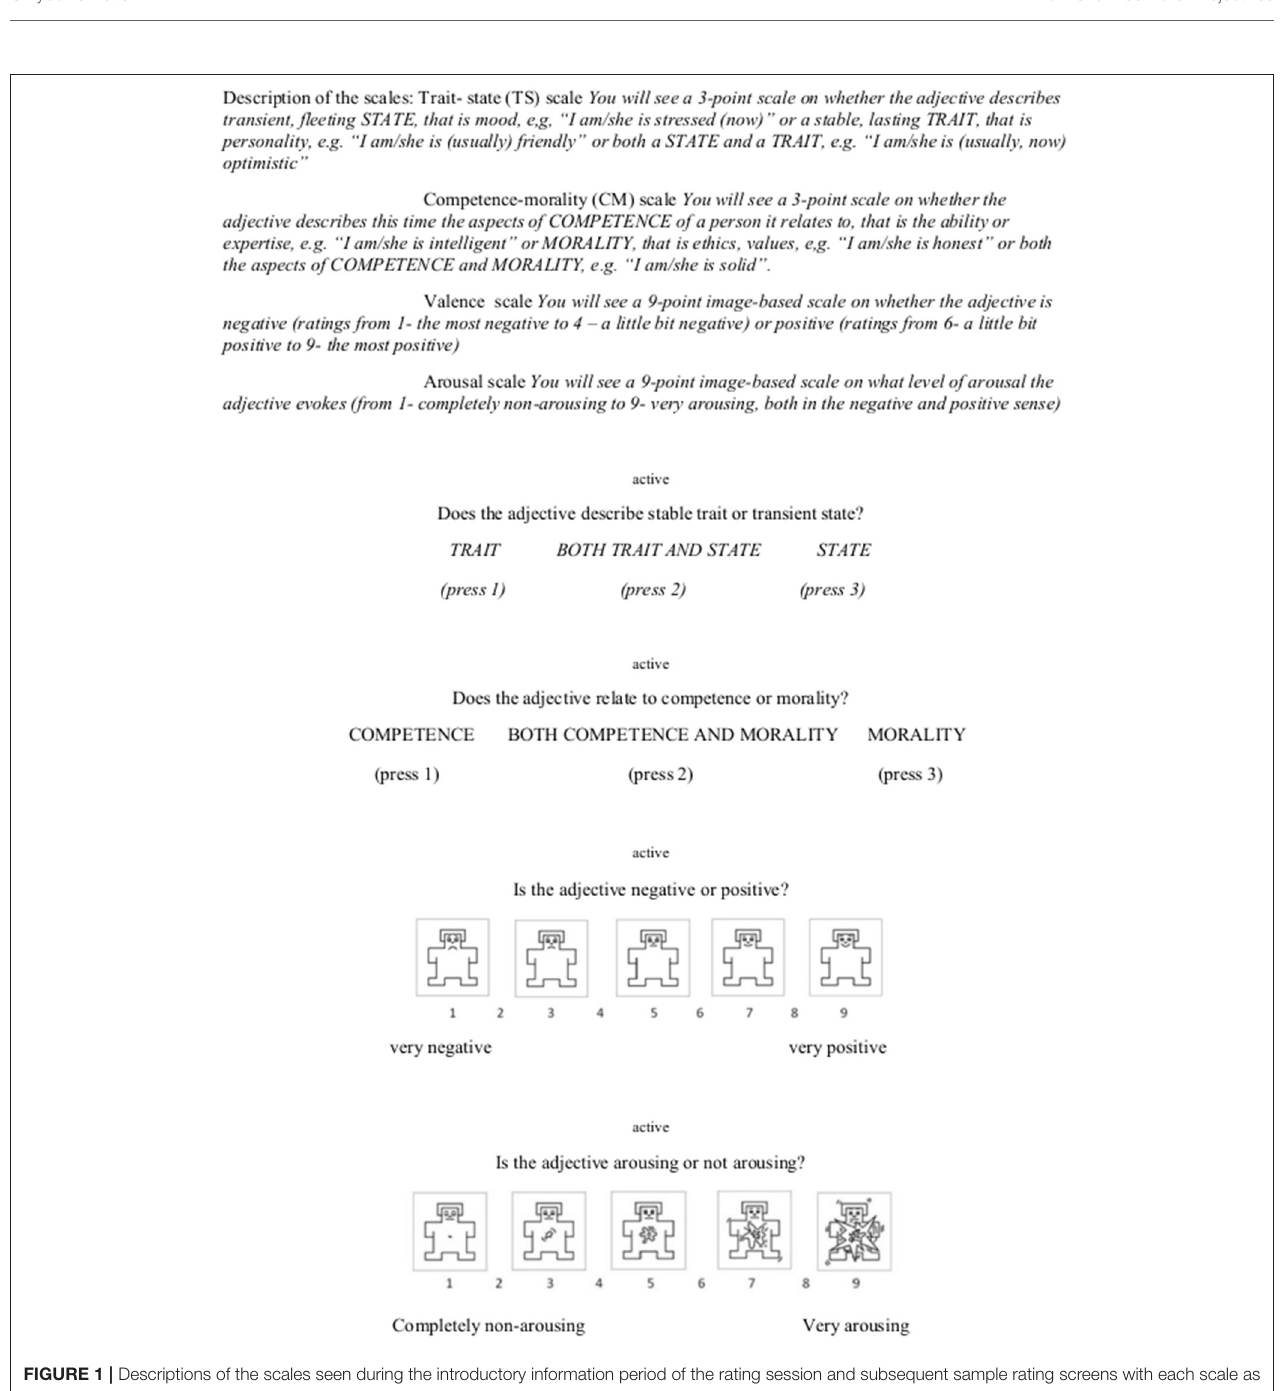
FIGURE 1 | Descriptions of the scales seen during the introductory information period of the rating session and subsequent sample rating screens with each scale as presented to the participants. Self-Assessment Manikin (SAM) based on (Bradley and Lang, 1999).